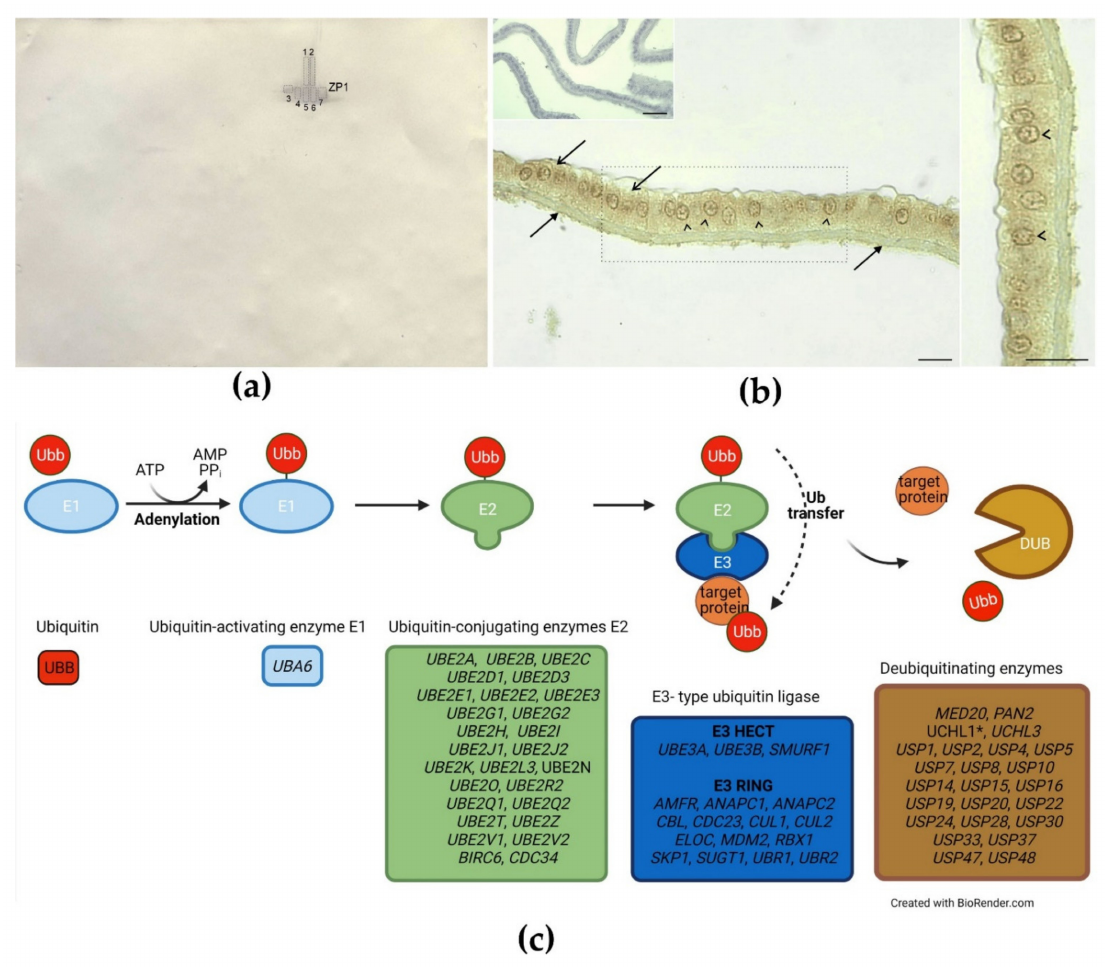
Figure 1. Ubiquitination of the inner perivitelline layer (IPVL) in mature oocyte: ( a ) Cross-reactivity between anti-ubiquitin antibodies and IPVL proteins after 2DE were analyzed by Western blot, and detected spots were identified as ZP1 proteins (the results of spot identification are presented in the Supplementary Materials, Table S4); ( b ) Immunohistochemical detection of ubiquitin in the IPVL and the granulosa cell (GC) layer. Counterstaining was performed with Mayer’s haematoxylin. Scale bars = 10 µ m. Frame indicates the location of the higher magnification view. Weak and moderate signals for ubiquitin are localized to the IPVL (arrows) and cytoplasm of GCs (open arrows). Note the strong linear staining pattern in the perinuclear cytoplasm of GCs (arrowheads). No immunopositive signal was observed for ubiquitin in the IPVL and the GC layer when the primary antibody was omitted (upper insert); ( c ) Transcripts/proteins identified in the IPVL participating in the protein ubiquitination pathway and deubiquitinating enzymes (DUB). Presented using the BioRender software. Description of gene/protein symbols are presented in the Supplementary Materials, Tables S1 and